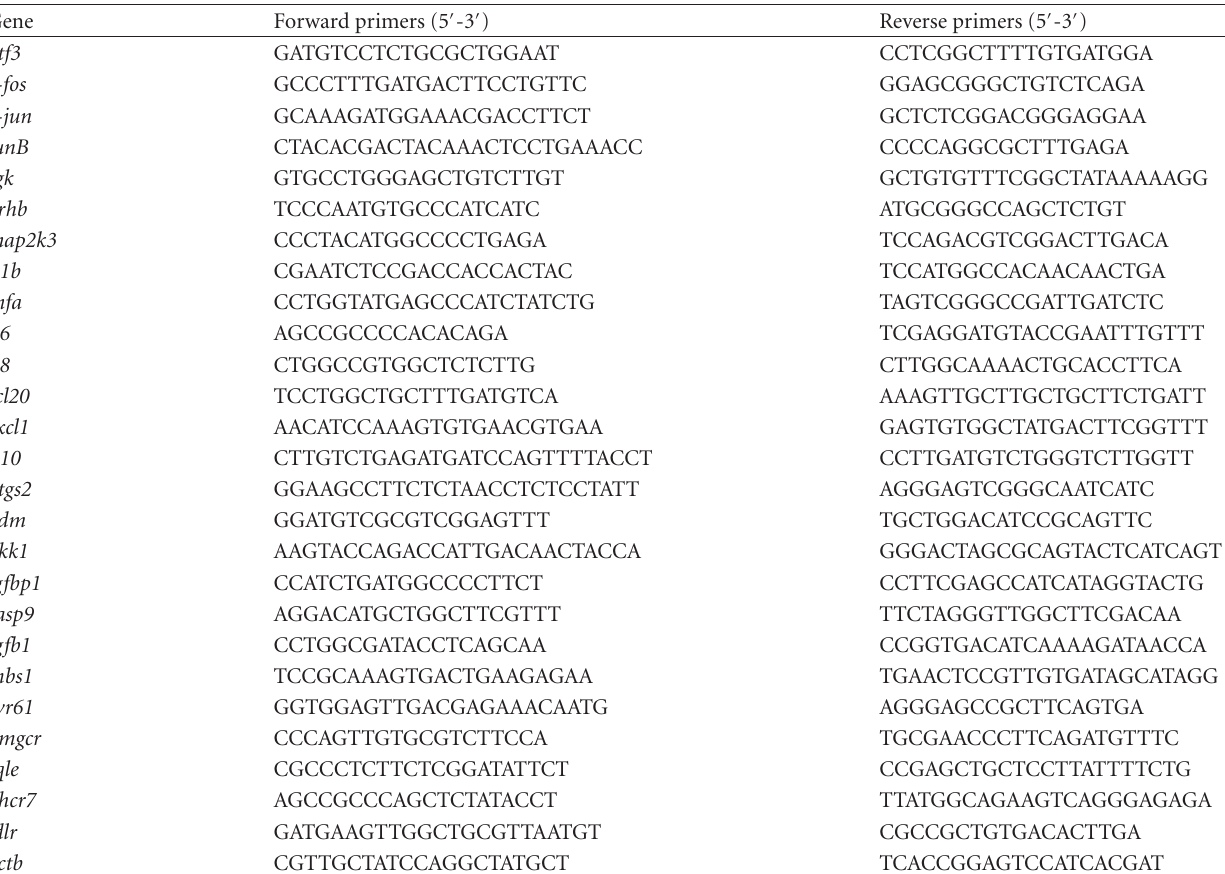
Table 1: DNA primers used for QRT-PCR